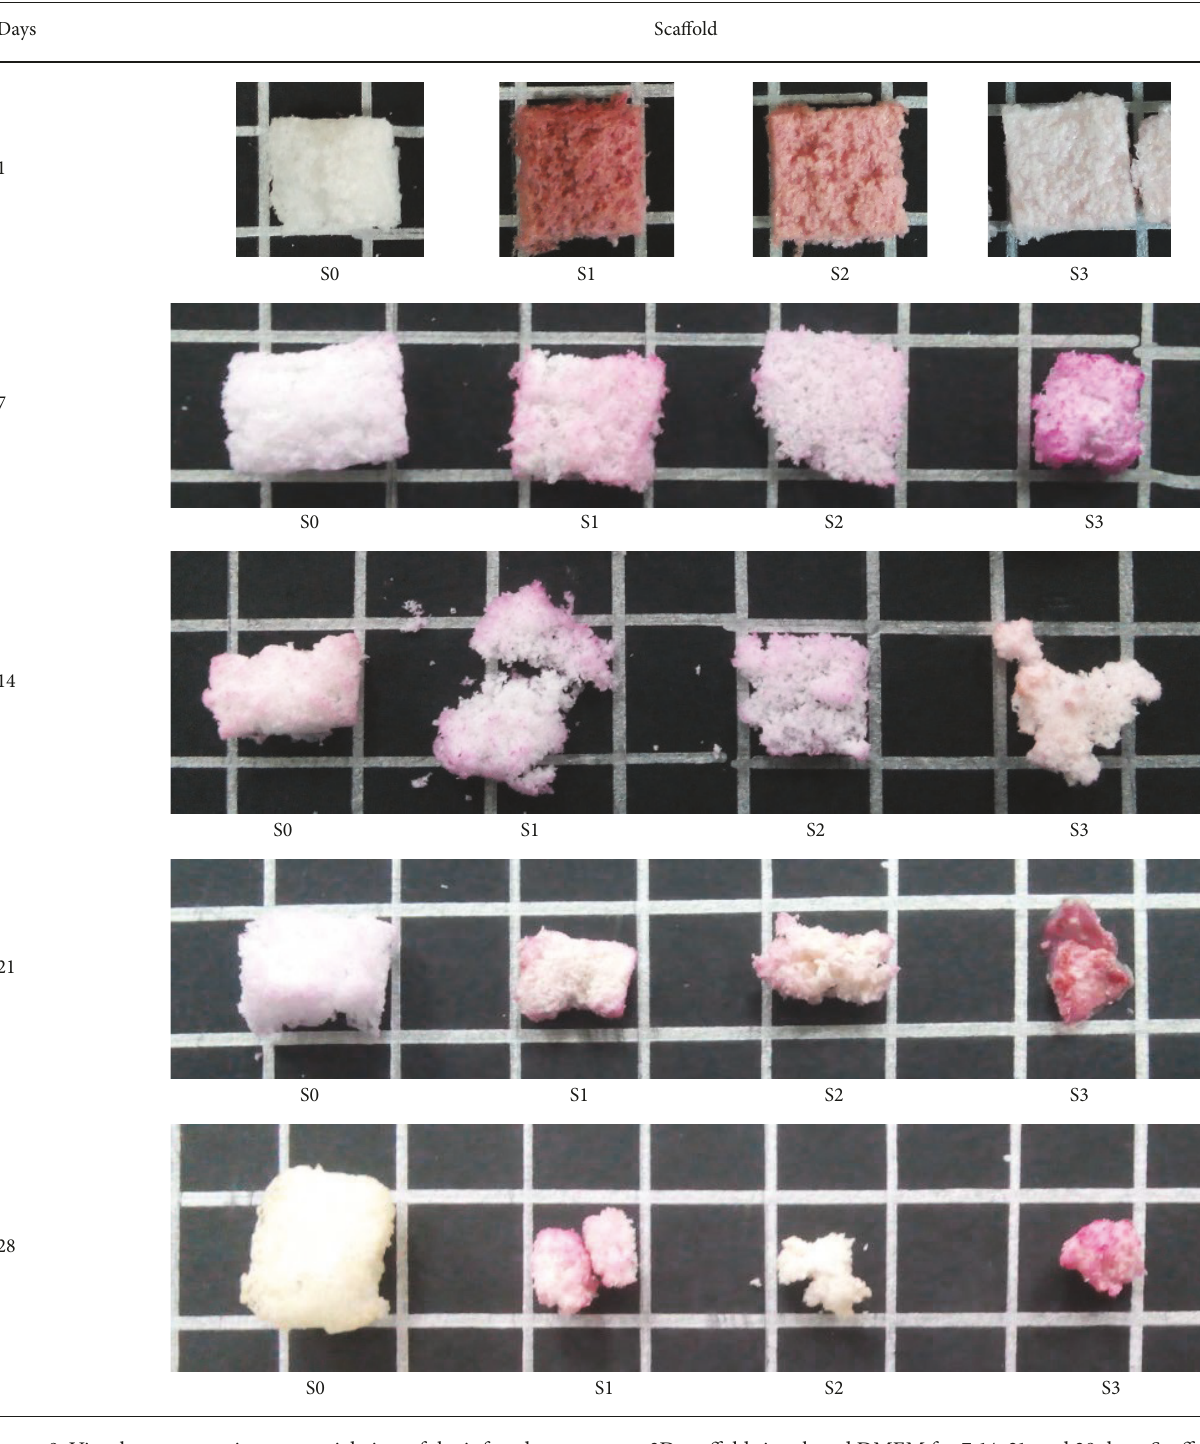
Figure 9: Visual assessment images: aerial view of the infused carrageenan 3D scaffolds incubated DMEM for 7, 14, 21, and 28 days. Scaffold were coded as S0 (naked 3D scaffold), S1 (2%, w/v) carrageenan, S2 (4%, w/v) carrageenan, and S3 (6%, w/v)